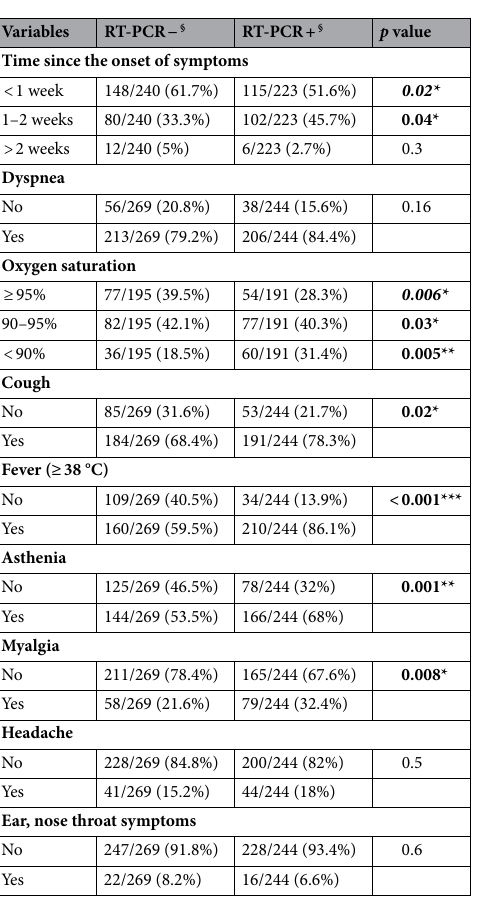
Table 2. Univariate associations between clinical features and RT-PCR status. P-values in bold correspond to significant associations between clinical features and RT-PCR status. Regarding variables with more than two levels, the p value in italics corresponds to the p-value considering all its levels. The p-values below are based on the Fisher or X 2 test for this variable that was dichotomized according to the level of the line. § Data refer to number of patients with percentage in parentheses. * p < 0.05, ** p < 0.005, *** p < 0.001 (corresponds to X 2 or Fisher